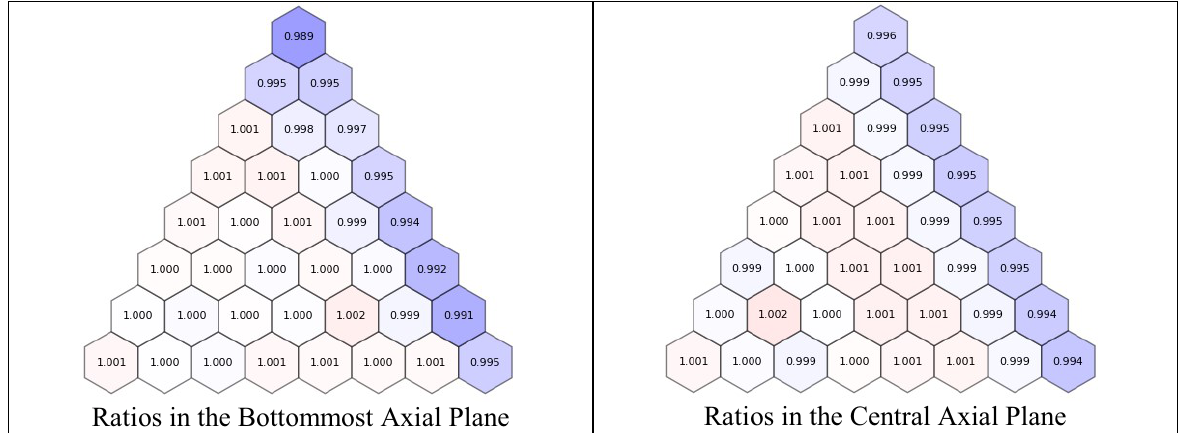
Figure 7. Ratio of DIF3D to MCNP Fluxes in Group